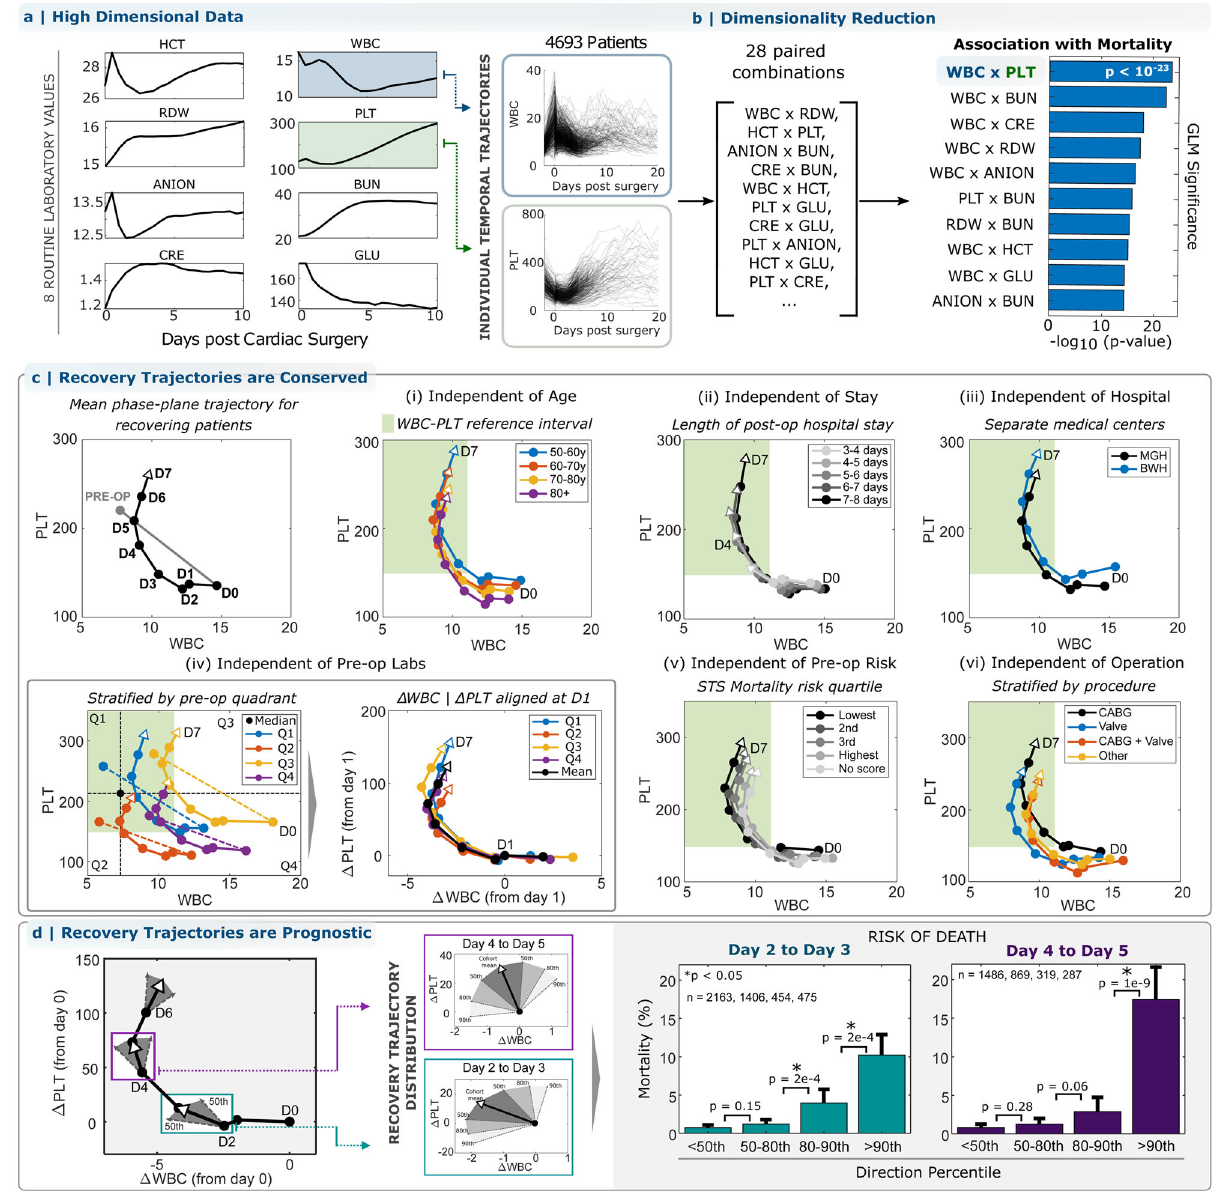
Fig. 1 | Analysis ofthe acutein fl ammatory response to non-emergency cardiac surgery in the WBC-PLT phase plane reveals a consistent shape of recovery. a High-dimensional trajectories of routine cellular and serum markers following cardiac surgery are associated with patient outcome. b Trajectories retain asso- ciationinreduceddimensions,withWBC-PLTasthe2Dcombinationmoststrongly associated with outcomes. c The average patient with a good recovery (surviving, LOS<14days)followsaconsistentrecoverytrajectoryintheWBC-PLTphase-plane, whichpersistsindependentof(i)age,(ii)lengthofstay,(iii)medicalcenter,(iv)pre- op marker values, (v) pre-op risk de fi ned by the STS risk score 15 , (vi) surgery sub- type, and gender and surgery year (Supplementary Fig. 4). d Deviation from the mean recovery trajectory is associated with adverse outcomes in retrospective analysis. The mean trajectory along with the 50th, 80th, and 90th percentiles for dailydirectionalchangesareshown.Directionaldeviationfromthemeantrajectory